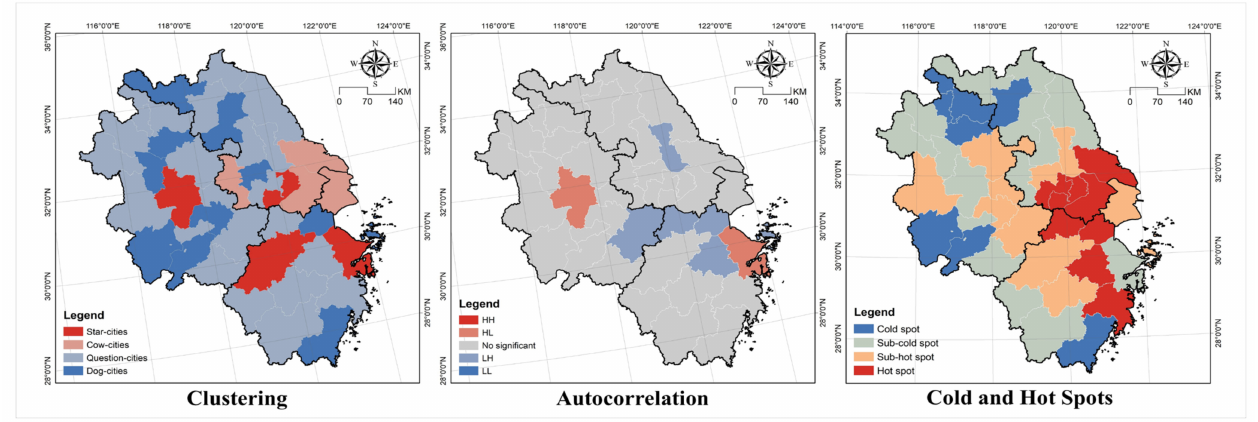
Figure 8. Spatial analysis of the evolution mode in